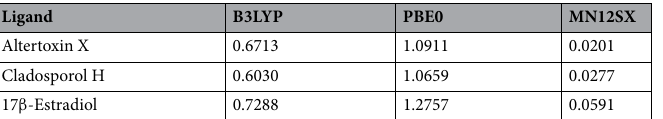
Table 5. Average GDK values for Altertoxin X, Cladosporol H, and 17 β -Estradiol considering three density functionals (B3LYP, PBEO and MN12SX) (all results in eV).